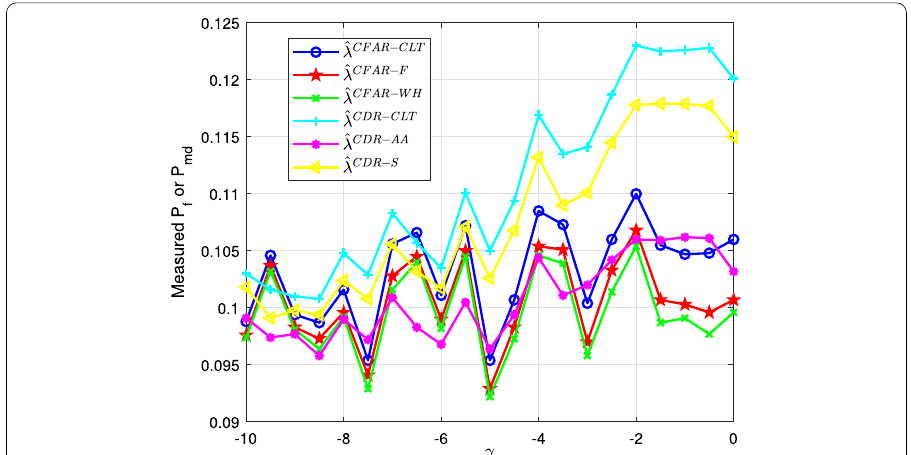
Fig. 4 Measured false alarm probability (for ˆ (cid:31) CFAR − CLT , ˆ (cid:31) CFAR − F and ˆ (cid:31) CFAR − WH ) and measured miss-detection probability (for ˆ (cid:31) CDR − CLT , ˆ (cid:31) CDR − F and ˆ (cid:31) CDR − S ) as a function of γ , using ˆ P f